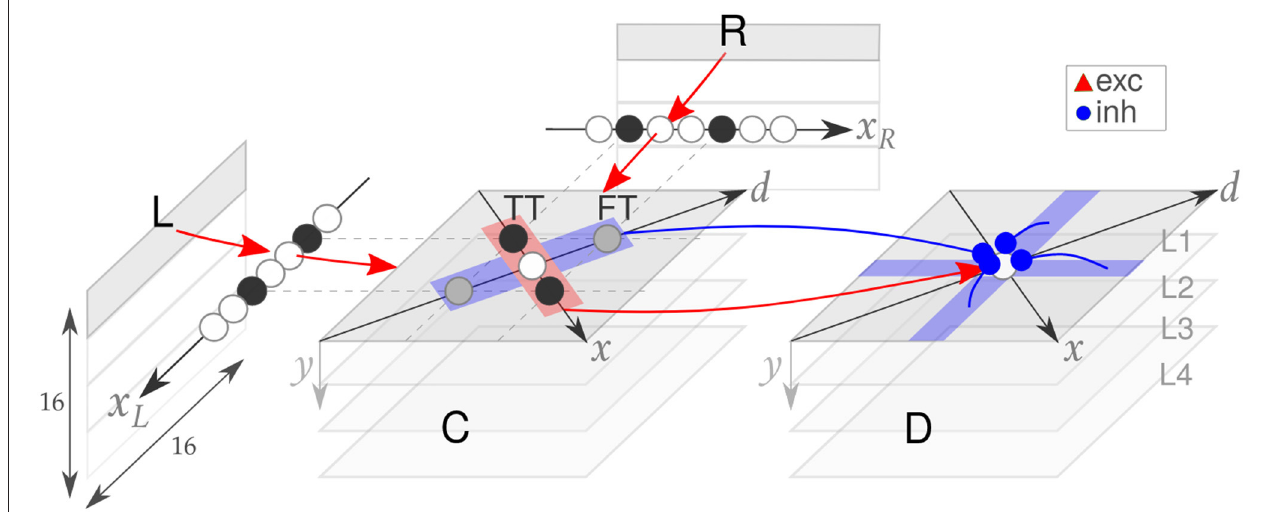
FIGURE 3 | The spiking neural network model. The input space of the retina (R, L) is downscaled and processed by four populations of coincidence (C) and disparity (D) neurons (first one highlighted in light gray). Excitatory (red) and inhibitory (blue) connections are shown. Adapted from Osswald et al. (2017).